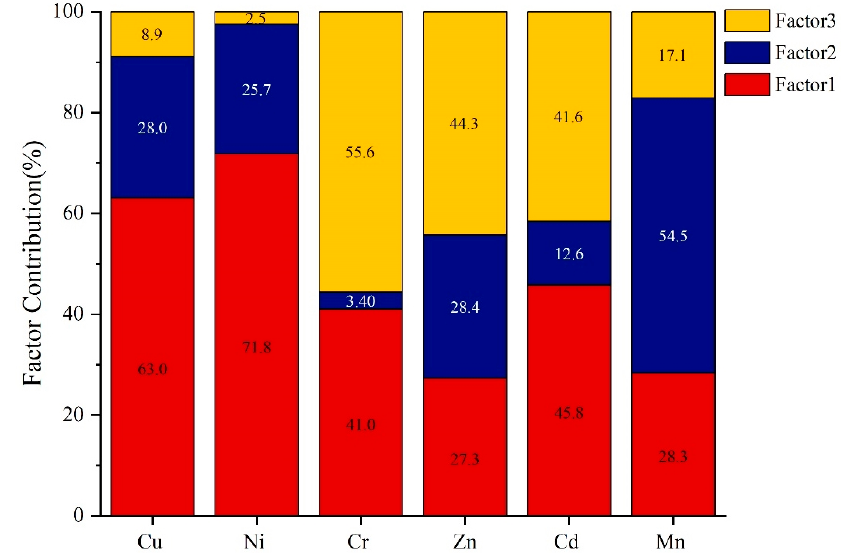
Figure 5. Analytical contribution of heavy metal PMF source.